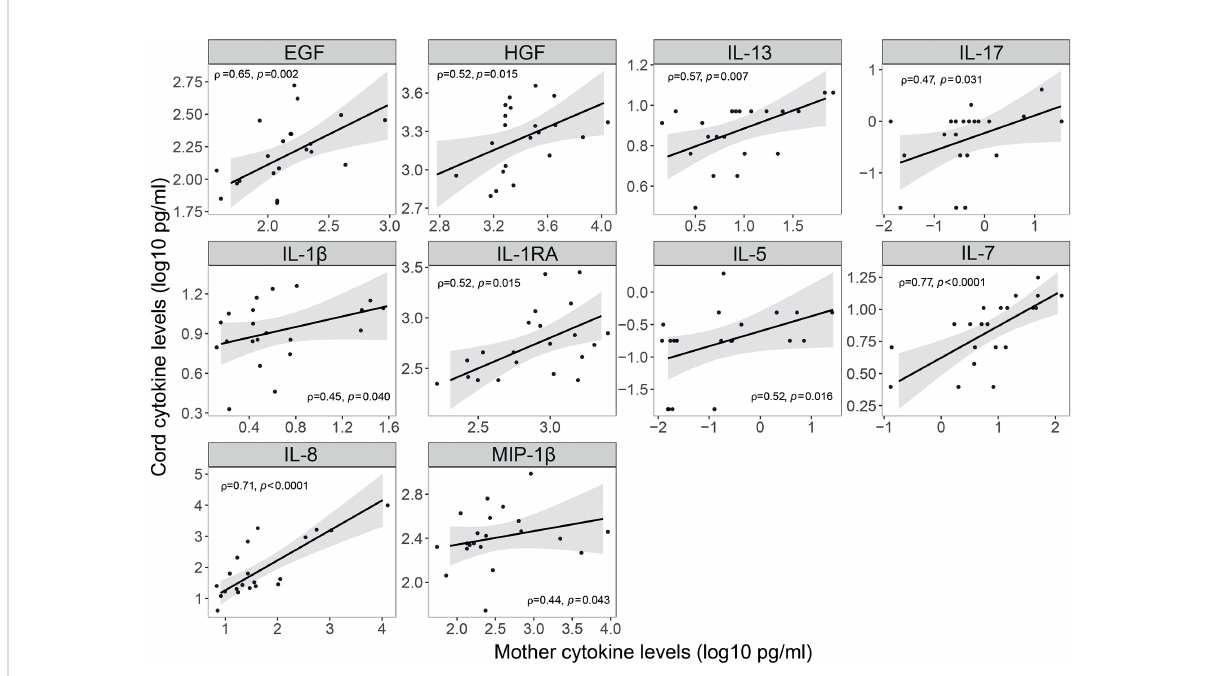
FIGURE 8 Correlations of cytokine, chemokine and growth factor concentrations in serum and cord blood from SARS-CoV-2 infected mothers. Correlations of in fl ammatory markers concentrations (log 10 pg/ml) in serum blood and cord blood from SARS-CoV-2 infected mothers are represented as a linear model with standard error as a con fi dence interval (shaded areas). Correlations were assessed by the Spearman test, and the rho ( r ) and p-values are shown. Only signi fi cant correlations are shown, the remaining are in Figure